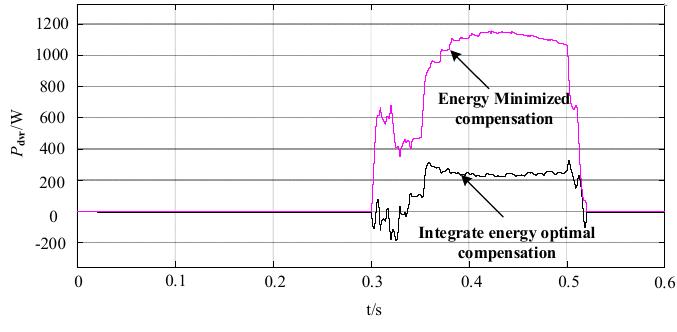
Figure 13. Output active power.